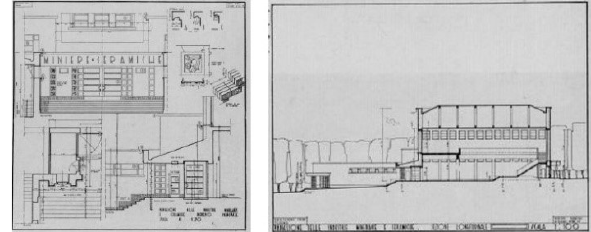
Figure 3. Project drawing of “Mines and Ceramics” pavilion.